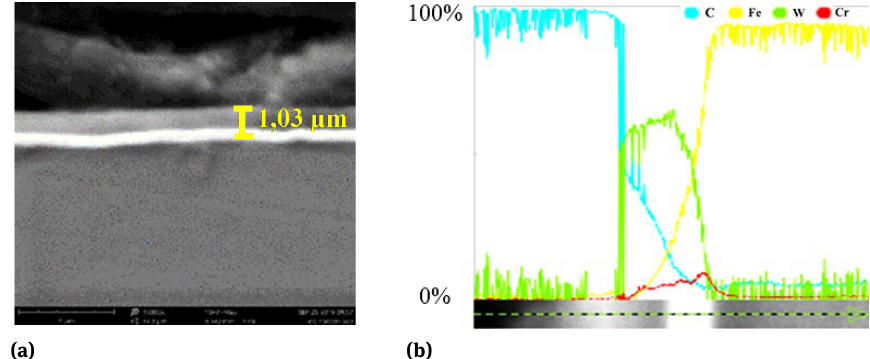
Figure 1: SEM images: a) microstructure of the a–C:H coating in the cross–section together with the thickness measurement, b) view of the cross–section of the a–C:H coating and linear distribution of the elements making up the coating.